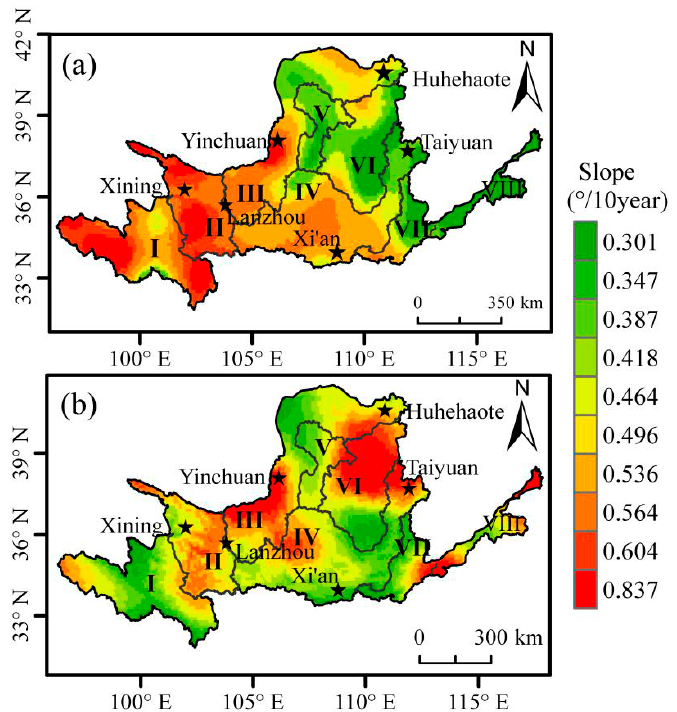
Figure 2. Variations of mean T max and T min during the growing seasons from 1982 to 2015 in the Yellow River Basin.